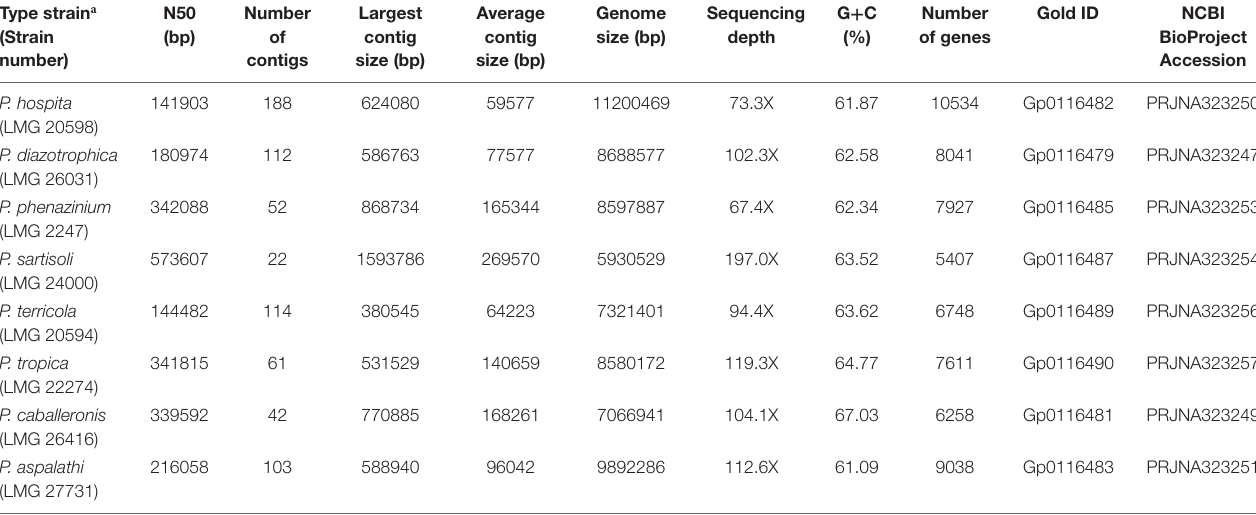
TABLE 1 | Details regarding the eight Paraburkholderia type strains sequenced at JGI for the GEBA Phase III